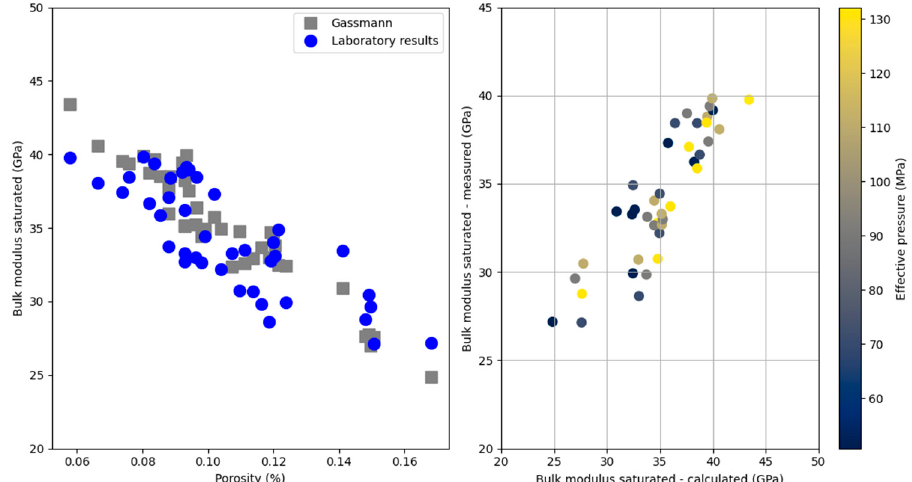
Figure 13. Relationship between porosity and bulk modulus for saturated samples–measured and calculated by Gassmann equation ( left ), and relationship of bulk modulus and calculated bulk modulus ( right ). Input elastic parameters are calcite: K = 76.8 GPa, water K = 2.1 GPa.